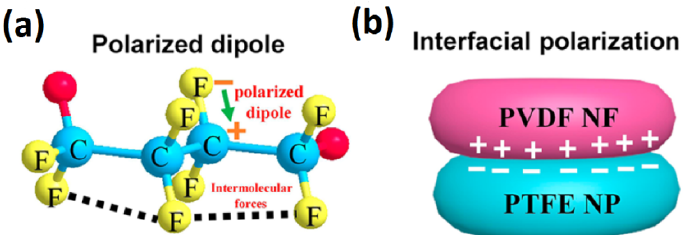
Figure 9. ( a )The polarized dipole of the electric charge existing in PVDF nanofibers that contain PTFE nanoparticles. ( b ) the interfacial concentration of the interaction between PVDF NF and PTFE NP. (Reprinted with permission from [59]. Copyright 2016 ACS Publications.).